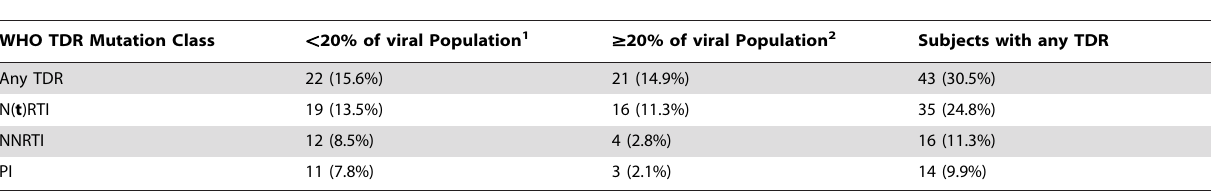
Table 1. Prevalence of low and high abundance Transmitted Drug Resistance Mutations (TDRs) by antiretroviral drug class.